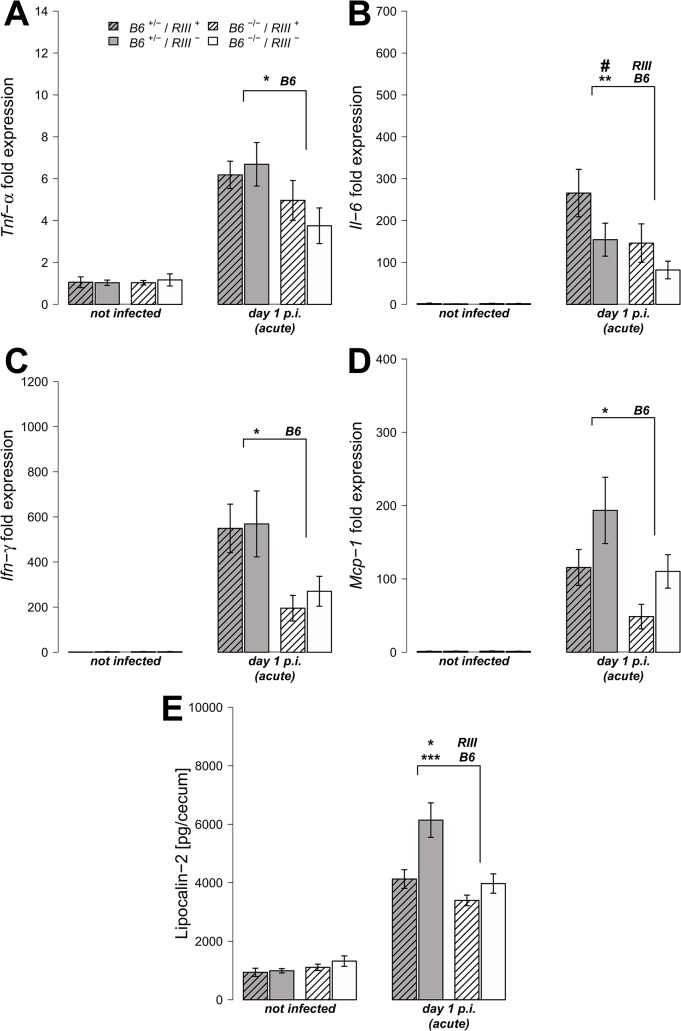

B4galnt2-dependent immune response after S. Typhimurium infection.(A-D) Relative gene expression of Tnf-α, Il-6, Inf-γ and Mcp-1 was determined by RT-qPCR analysis. Values were normalized to Gapdh and Hprt and calculated as fold expression compared to the non-infected samples of each respective genotype. (E) Lipocalin-2 levels were measured by ELISA in supernatants of cecal homogenates (N = 3–11 per group) before- and one day p.i. with S. Typhimurium, showing a clear increase with infection (Z = -2.219, P = 0.0261; Wilcoxon test via Monte-Carlo resampling) and differences between B6 and RIII genotypes (S1 Table, # P < 0.100, * P < 0.050, ** P < 0.010, *** P < 0.001; error bars indicate SEM).